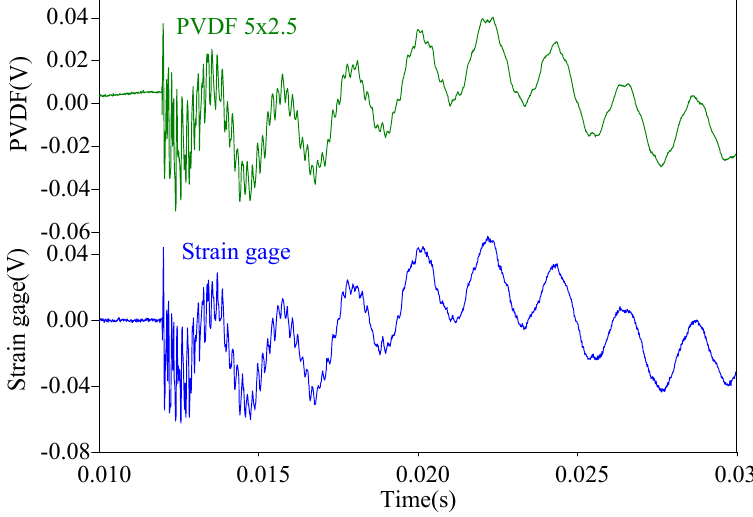
Figure 18. Measurement results of PVDF 5  2.5 and the strain guage with impact on location B.